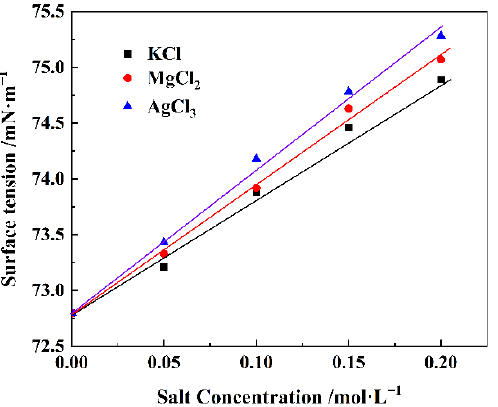
Figure 11. Surface tension of the solution as a function of inorganic salt concentration.